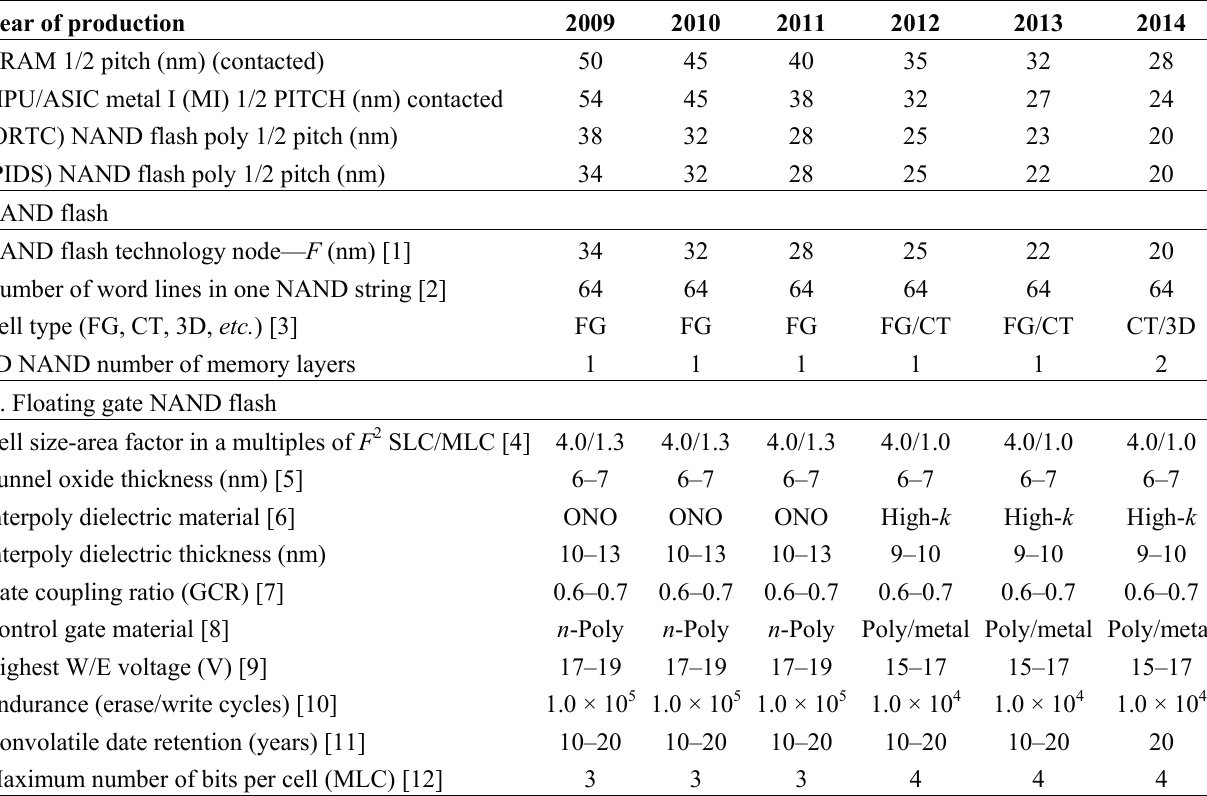
Table 2. ITRS Scaling projections for floating-gate NAND Flash